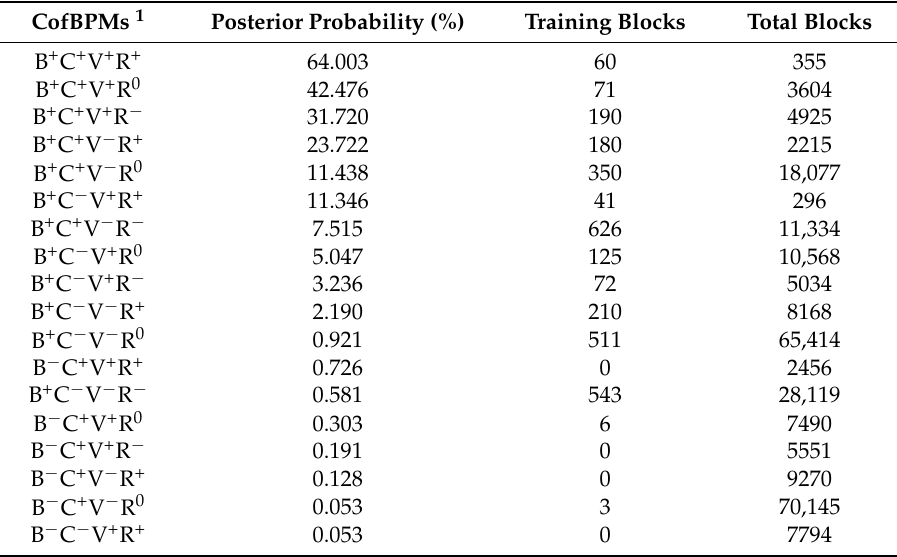
Table 5. Combination of binary predictive maps with different posterior